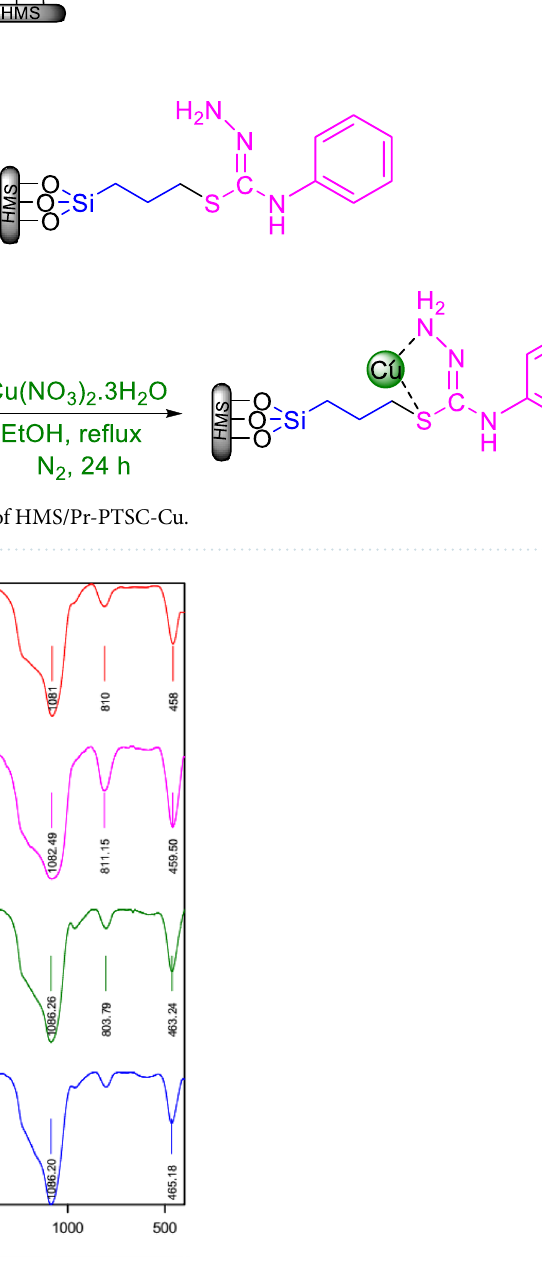
Figure 3. FT-IR spectra of HMS (a) and HMS/Pr (b), HMS/Pr-Xa (c) and HMS/Pr-Xa-Ni